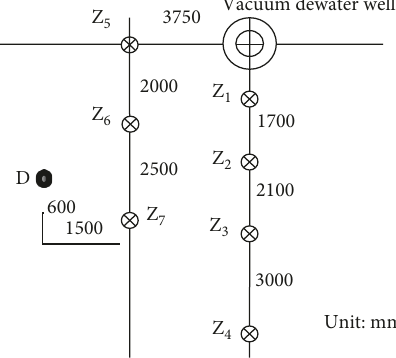
1 –z 7 : vacuum pressure